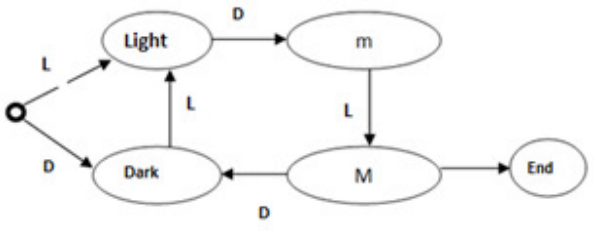
Figure 8. Entries that change the status of the finite state